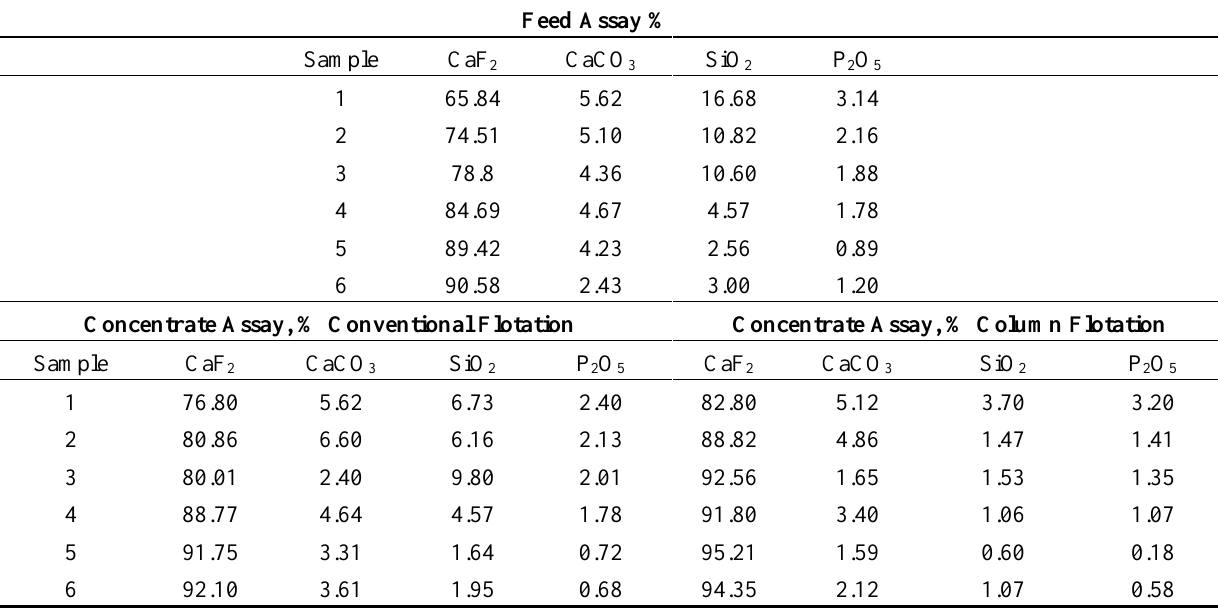
Table 3. Kadipani Flotation Data